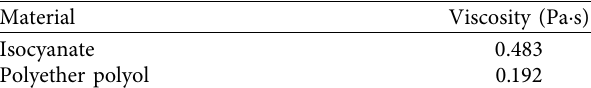
Figure 5: Viscosity change during the reaction. Table 1: Viscosity of materials.